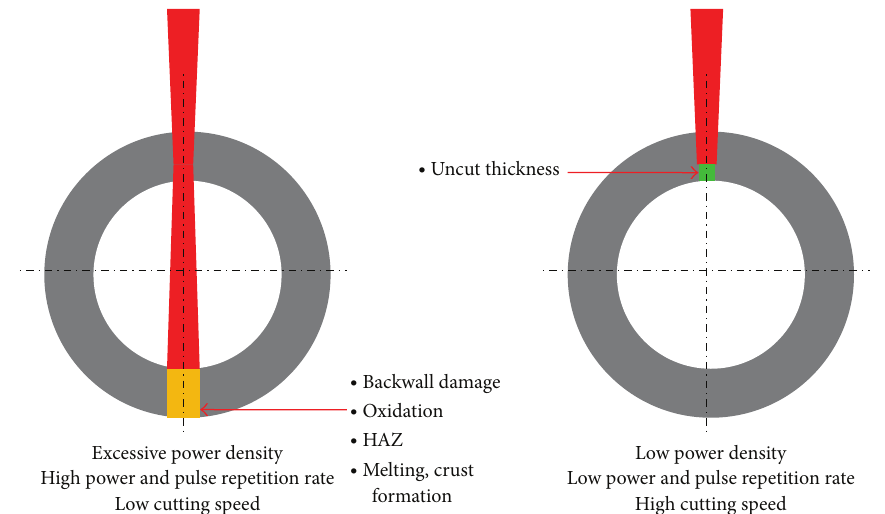
Figure 2: Common limitations in laser tube microcutting with ns-pulse laser sources.